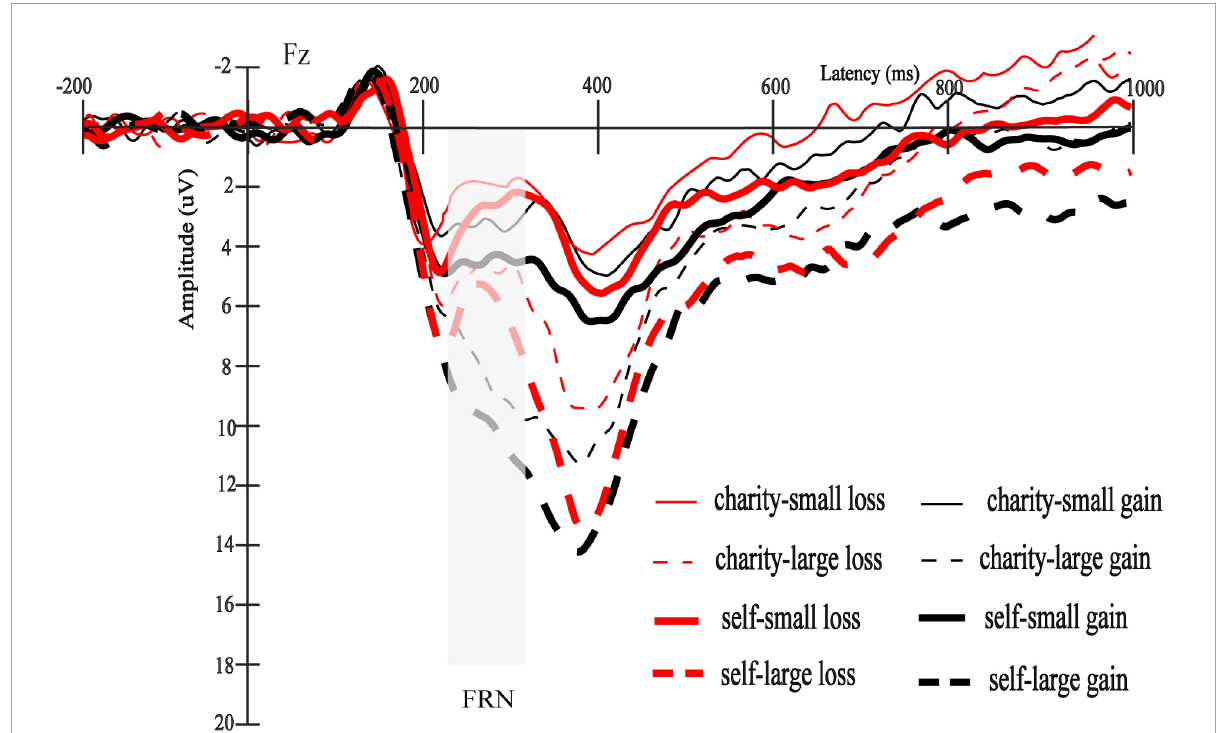
FIGURE4 The total average FRN waveforms for all